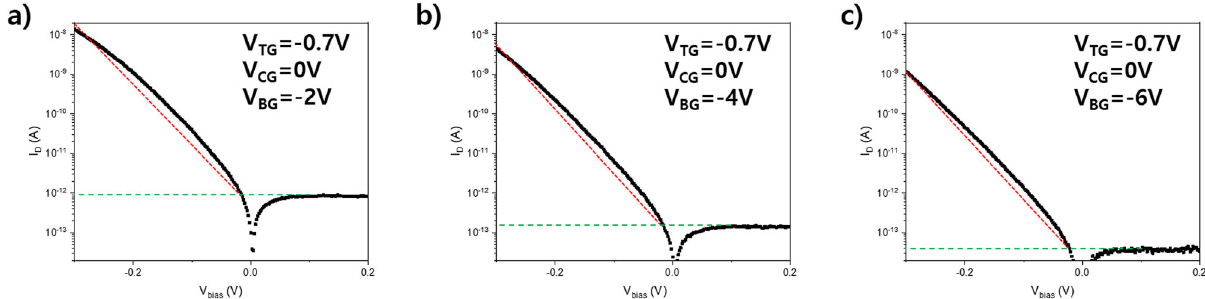
Fig. 3 Slopes of DS Schottky diode versus ideal diode and recorded ideality factor in 2D vdW material-based diode. Comparison of slopes between the DS Schottky diode and an ideal diode. Black and red dotted data represent those of the DS Schottky diode and an ideal diode, respectively. The Green dashed line indicates off-state current in the reverse bias regime. a DS Schottky diode curve at V BG = − 2 V. b DS Schottky diode curve at V BG = − 4 V. c DS Schottky diode curve at V BG = − 6 V. The DS Schottky diode exhibits a η ave_3dec of 0.98, 0.95, 0.94 when V BG = − 2, − 4, and − 6 V, respectively with fi xed top- and control- gate voltage of V TG = − 0.7 V and V CG =